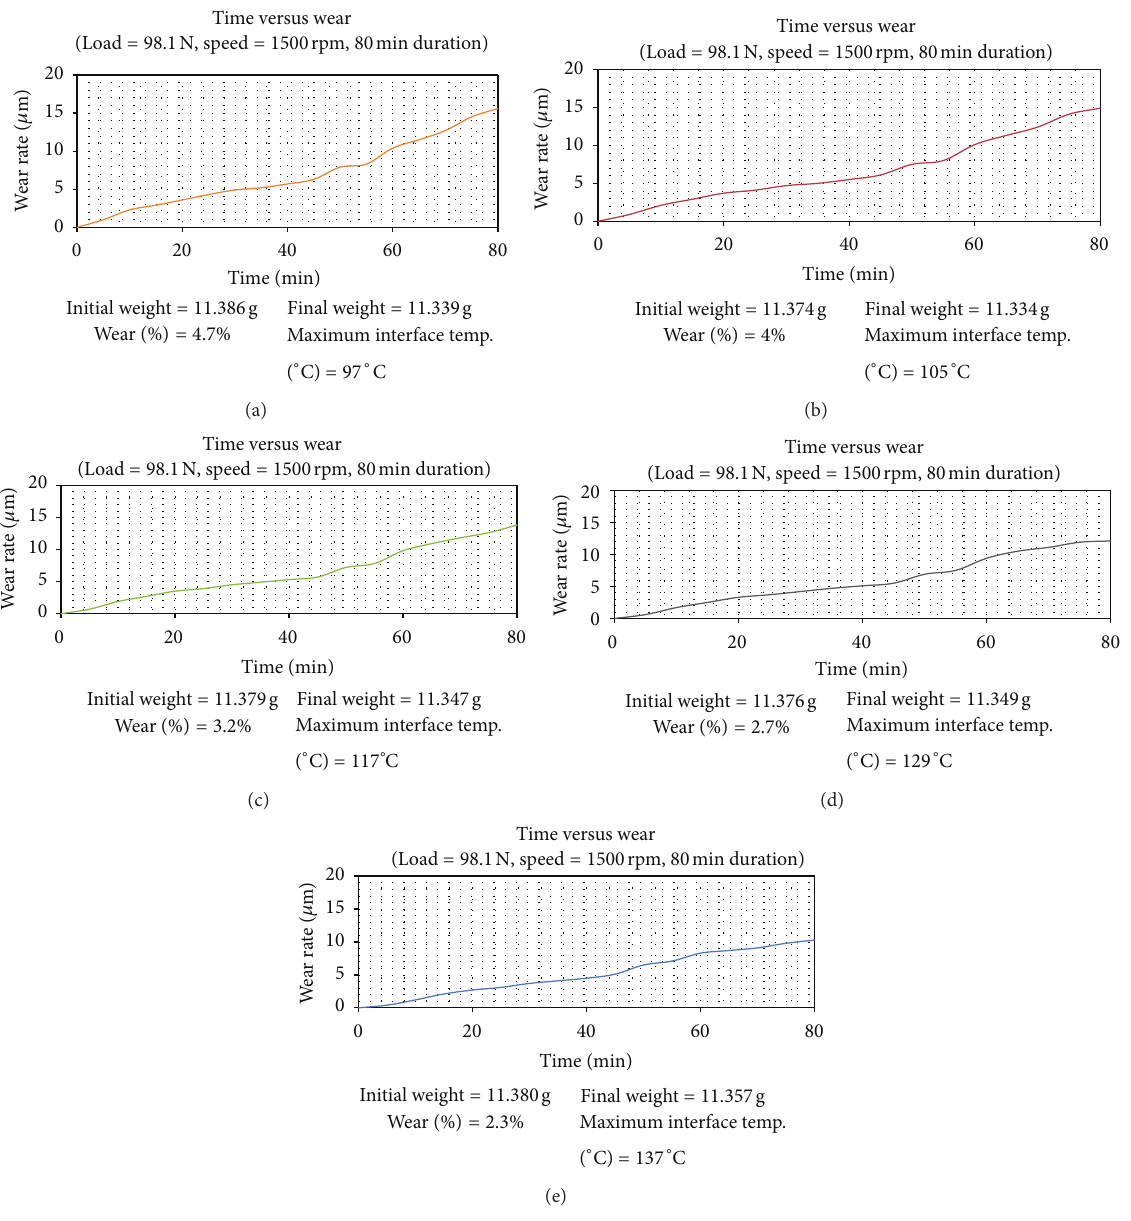
Figure 11: (a) Time versus wear for Na01. (b) Time versus wear for Na02. (c) Time versus wear for Na03. (d) Time versus wear for Na04. (e) Time versus wear for